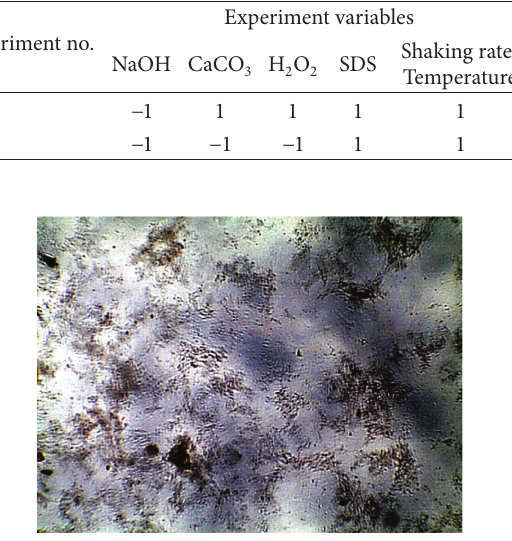
Figure 1: Agglutination reaction of S. typhimurium ATCC 14028.